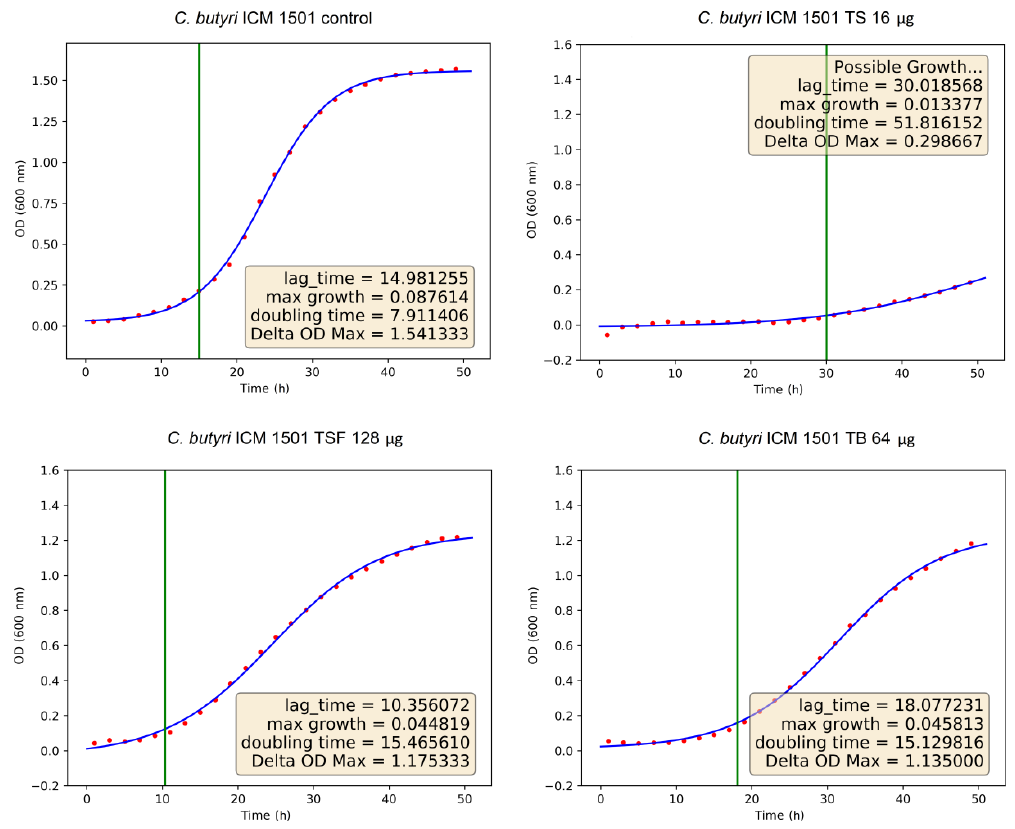
Figure 9. Sample regression curves of selected data showing the e ff ect of examined 1,3,4-thiadiazoles on Candida species.